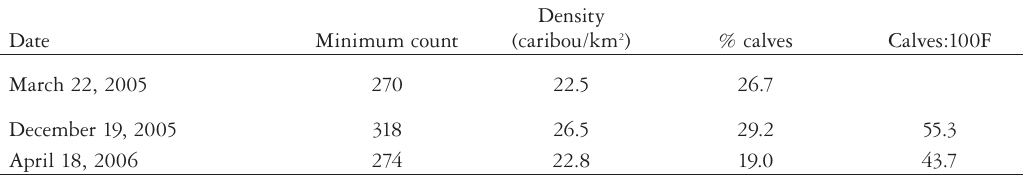
Table 1. Population dynamics for woodland caribou ( Rangifer tarandus caribou ) on George’s Island, Labrador, Canada.